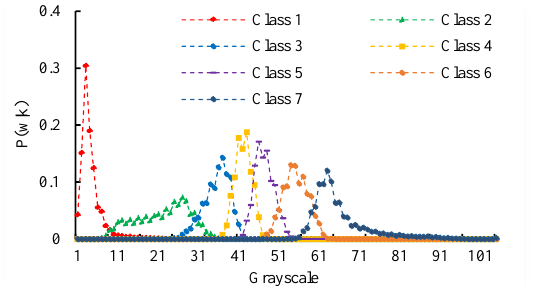
Figure 6 The probability distributions of the grayscale values given different geo-object classes